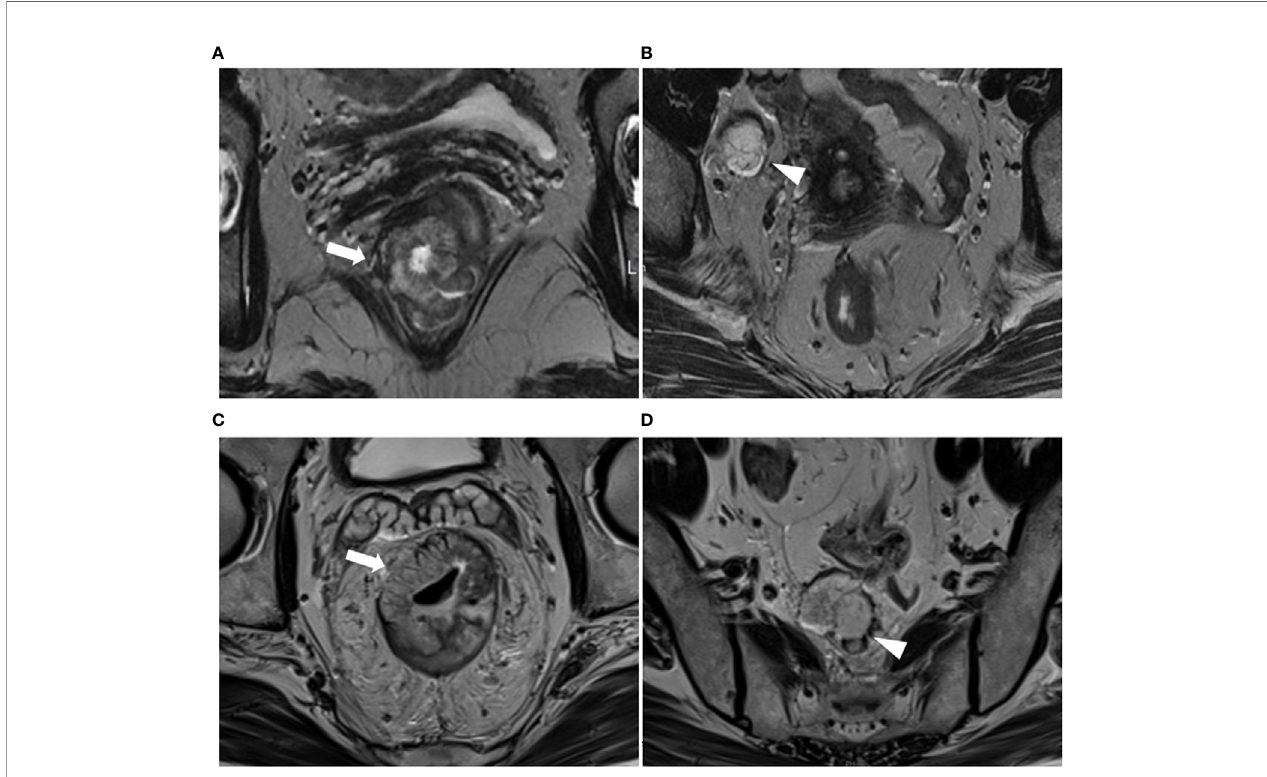
FIGURE 2 | (A, B) A 61-year-old woman with RMAC in the lower rectum in the primary (training) cohort. (A) Oblique-axial T2WI demonstrating a lower rectal tumor with high signal intensity (arrows). (B) Right lateral pelvic tumor deposit with mucin content conspicuity (arrowhead). (C, D) A 65-year-old man with RMAC in the middle rectum in the validation cohort. (C) Oblique-axial T2WI demonstrating an RMAC (arrows). (D) Presacral mucin deposit demonstrating the similar presence of a primary rectal lesion